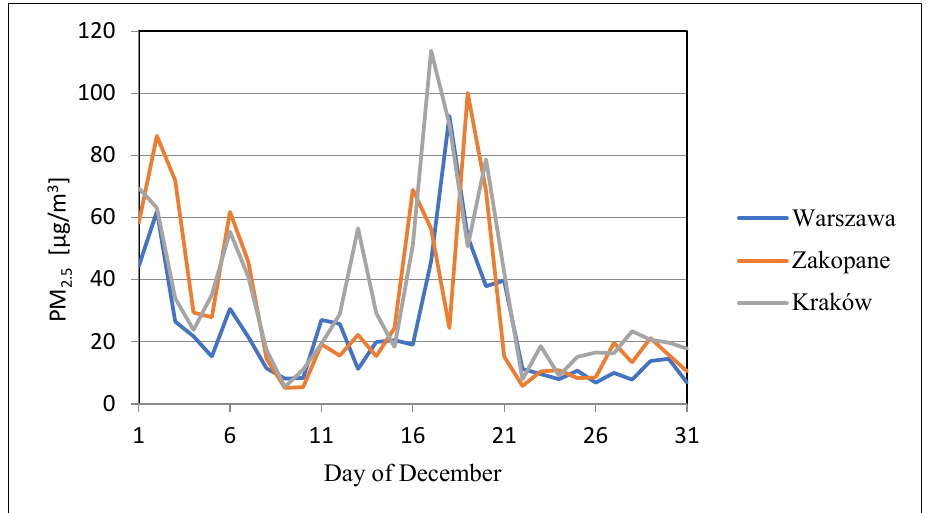
Figure 2. Daily average urban district PM 2.5 concentration in December 2018 [14].